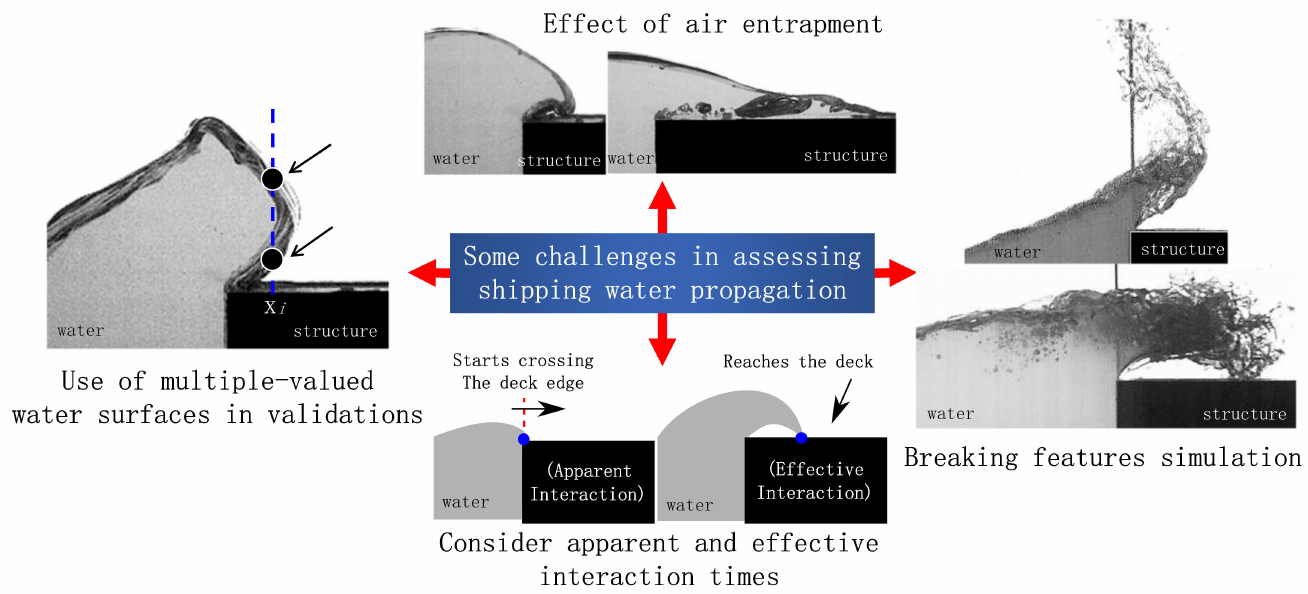
Figure 16. Some challenges in assessing green water propagation. Upper and left pictures are modified from the open-source database provided by [12]. The pictures on the right are modified from